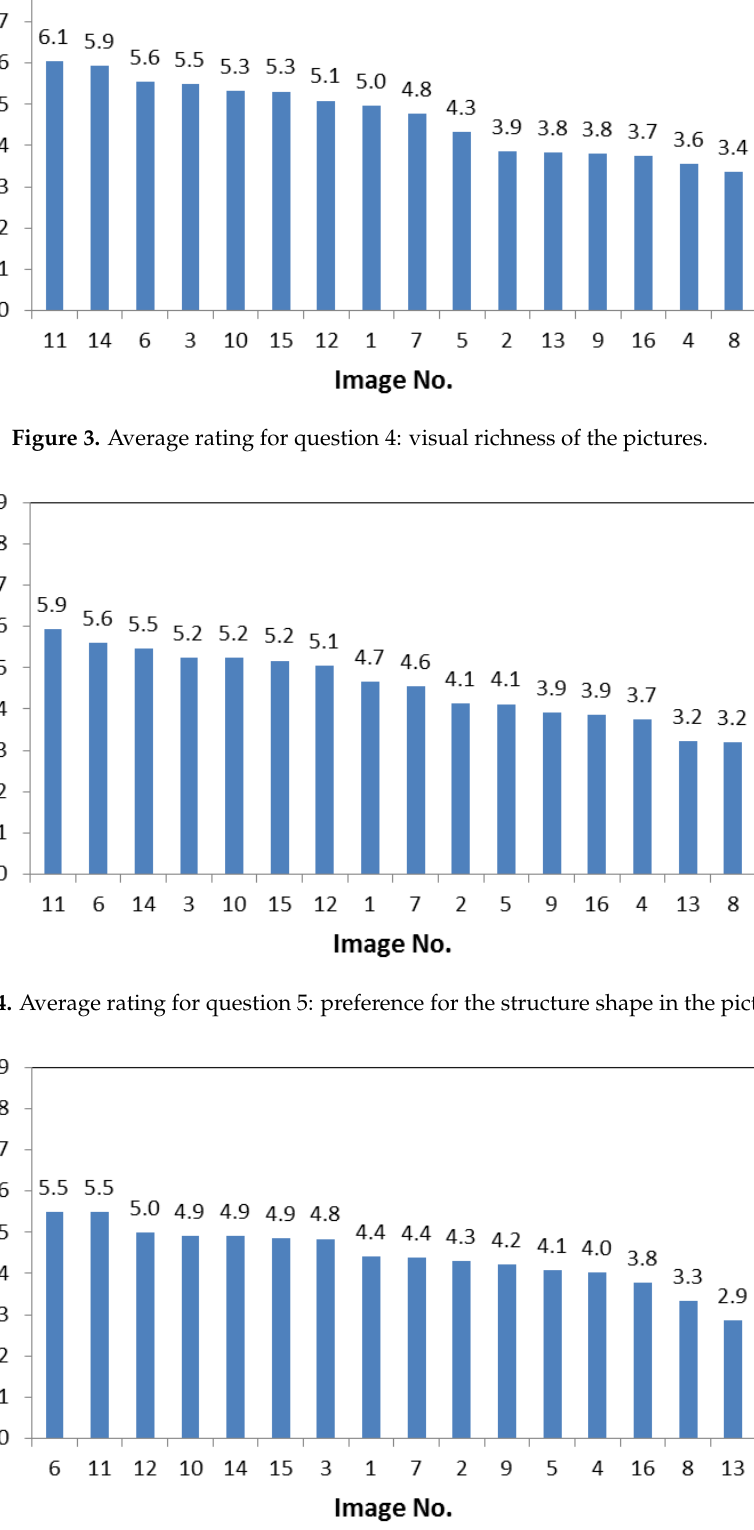
Figure 5. Average rating for question 6: perceived safety of structure in the picture.